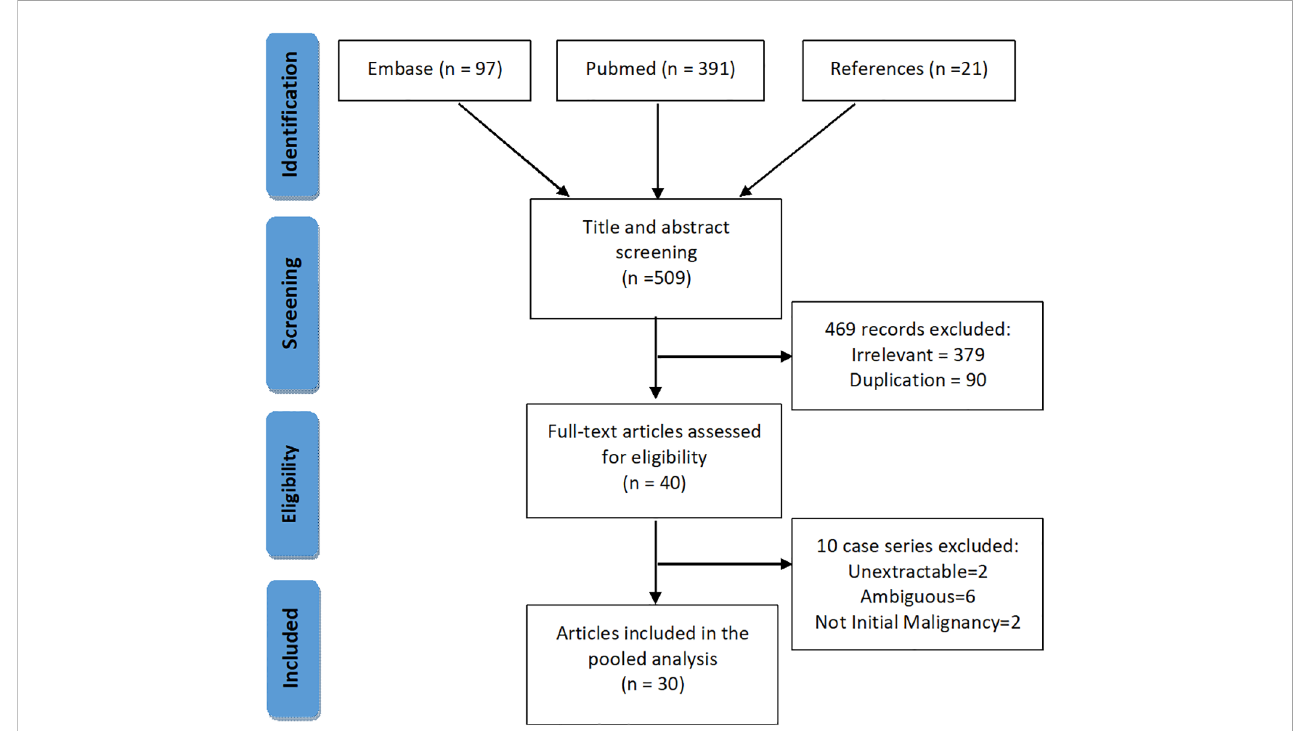
FIGURE 1 PRISMA chart showing the inclusion and the exclusion process for the literature